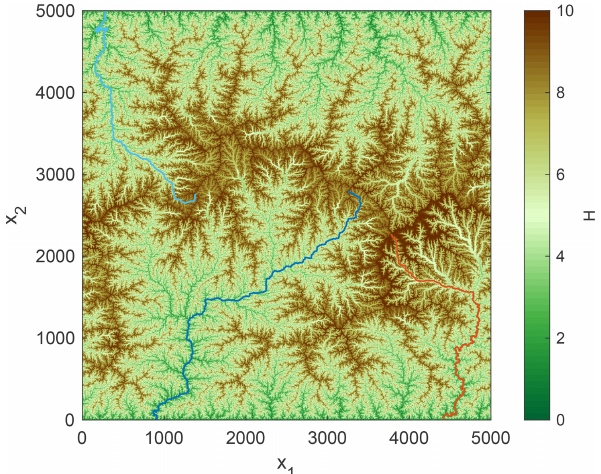
Figure 7. Topography at t = 25 for H e = 8, H f = 10, K g = 2, and K = 1.